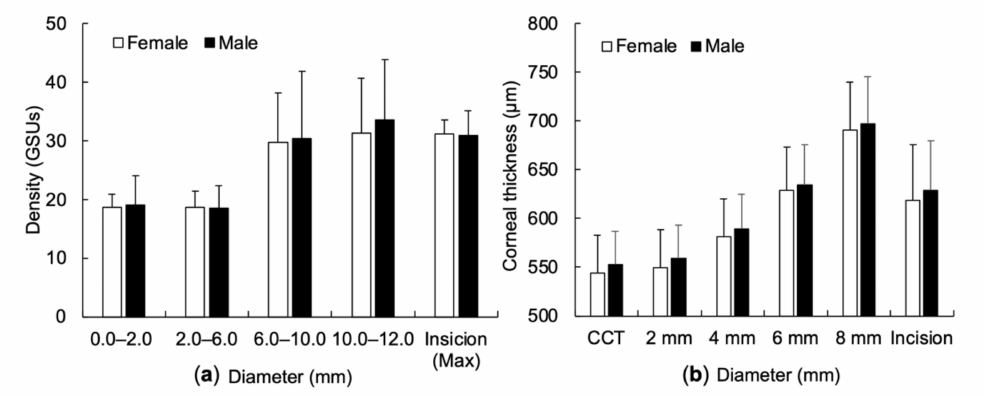
Figure 2. Preoperative corneal optical density and corneal thickness with sex. ( a ) Corneal optical density between sex in either radial diameter or incisional site. ( b ) Corneal thickness between sex in either radial diameter or incisional site. Density = corneal optical density; GSUs = grayscale units; CCT = central corneal